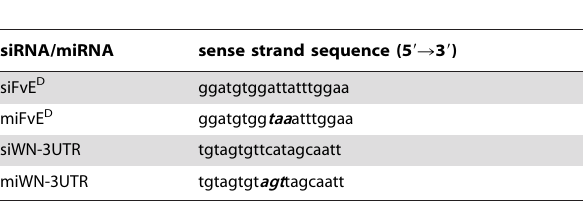
Table 1. Sequence of siRNA and miRNA mimicking